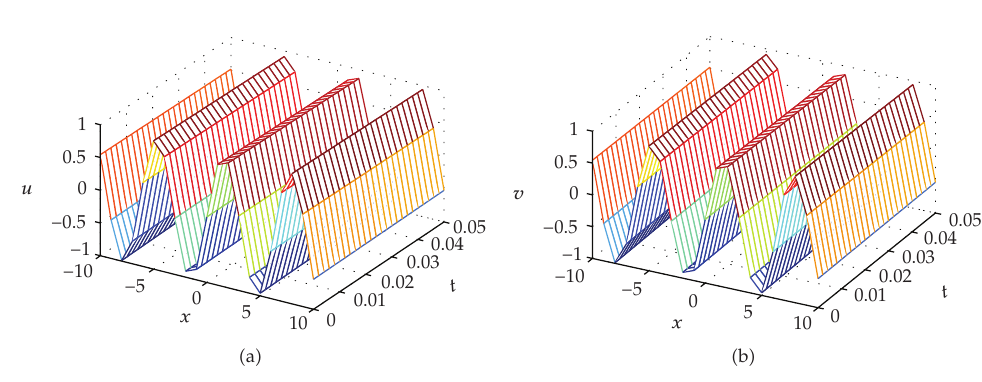
Figure 2: Explicit numerical solutions with h (cid:8) − 1, α (cid:8) β (cid:8) 1.